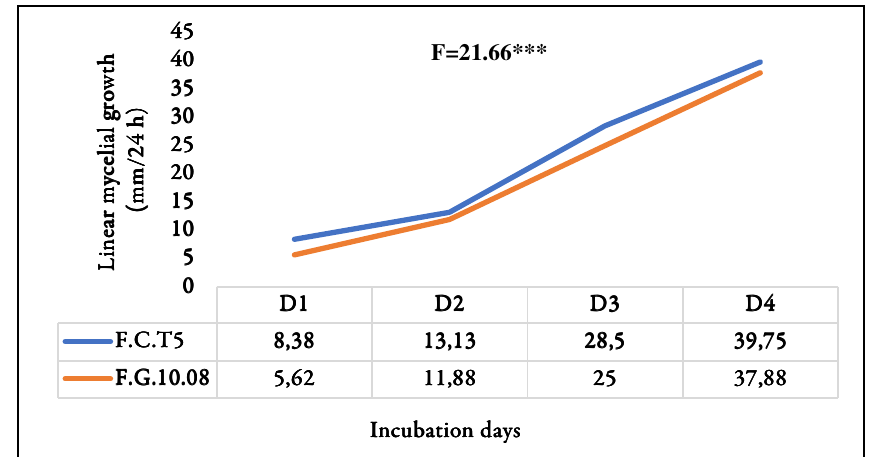
Figure 3. Linear mycelial growth of the two isolates on PDA medium (mm/24 h)